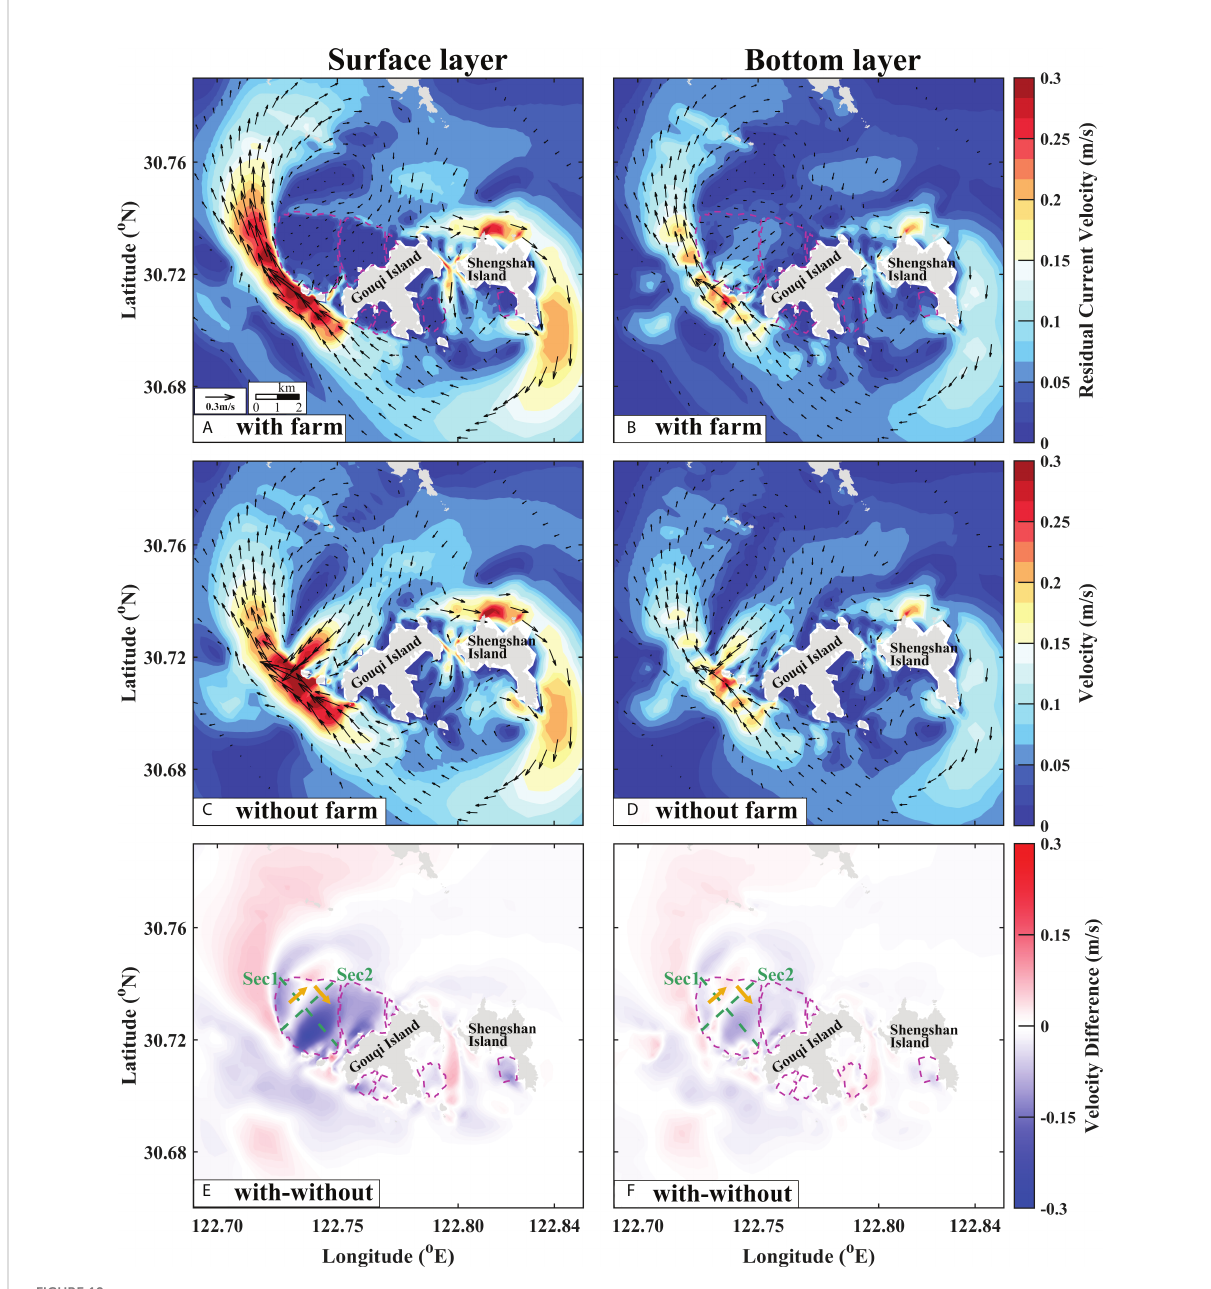
FIGURE 10 Modeled Eulerian residual tidal current. (A, B) with and (C, D) without mussel farms at the surface (Left, depth=0.1d, where d is local depth) and bottom (Right, depth=0.8d) layer. (E, F) is the difference of residual current with and without farm at the surface (Left) and bottom (Right) layer. The orange arrows show the positive direction of water transport across Sec1 and Sec2 in the fi gure. Pink dash lines indicate the borderlines of mussel